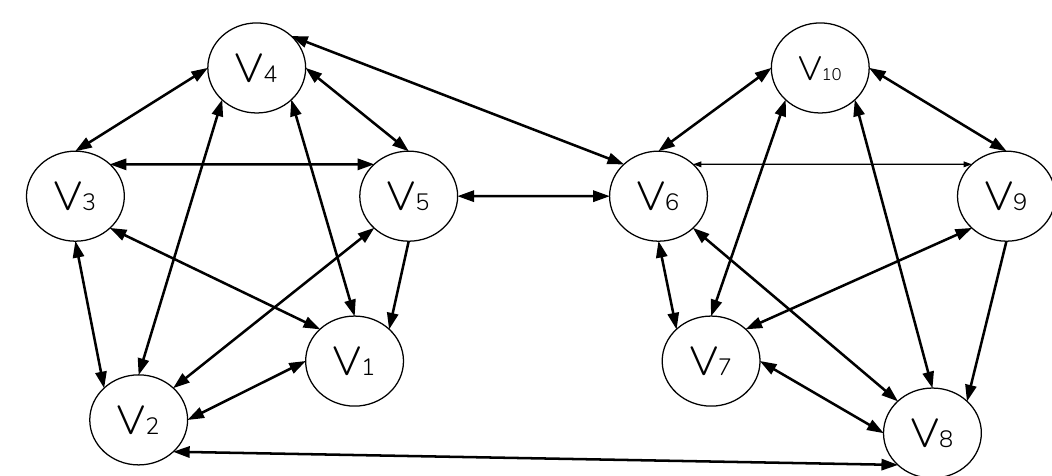
Figure 3. Two quorum slices intersecting at nodes { v 2 , v 4 , v 5 , v 6 , v 8 }